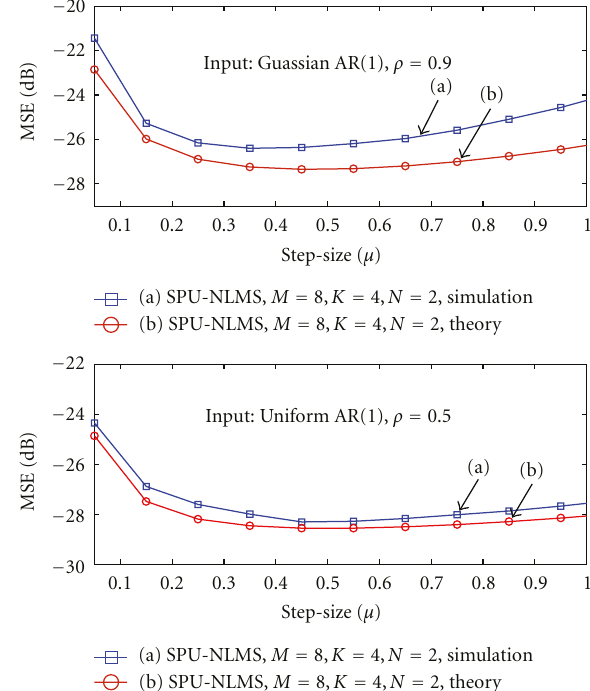
Figure 4: Steady-state MSE of N -Max NLMS with M = 8 and N = 6 as a function of the step size in nonstationary environment for di ff erent input signals.